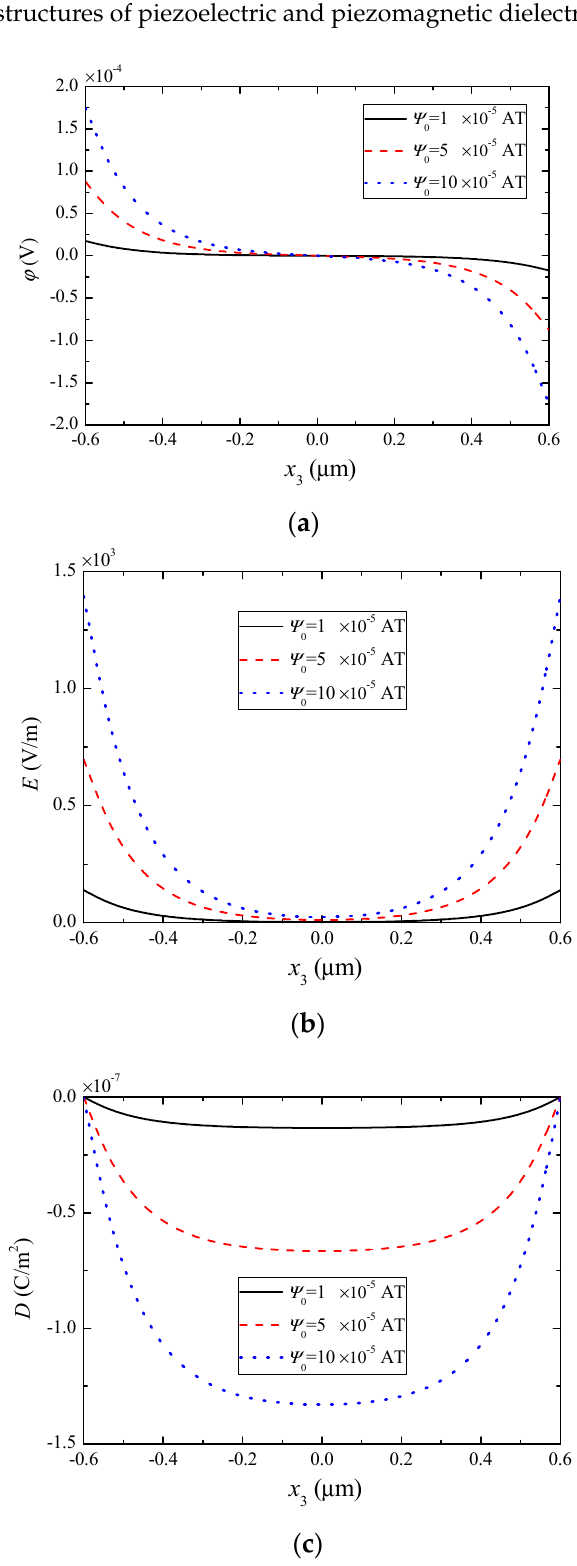
ψ =1 10 m n × . ( a ) when 21 3 0 0